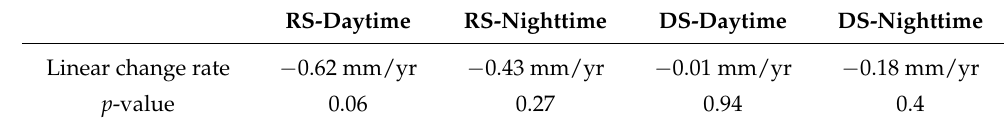
Table 1. The change trend of daytime and night-time precipitation in rainy season and dry season.